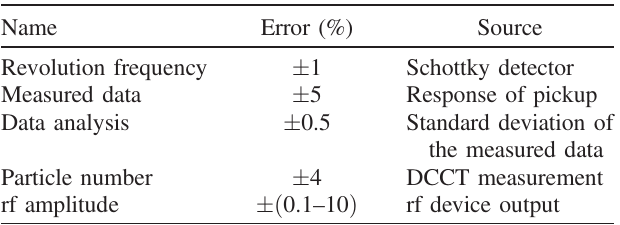
TABLE III. Estimate errors for the bunch length measurement.